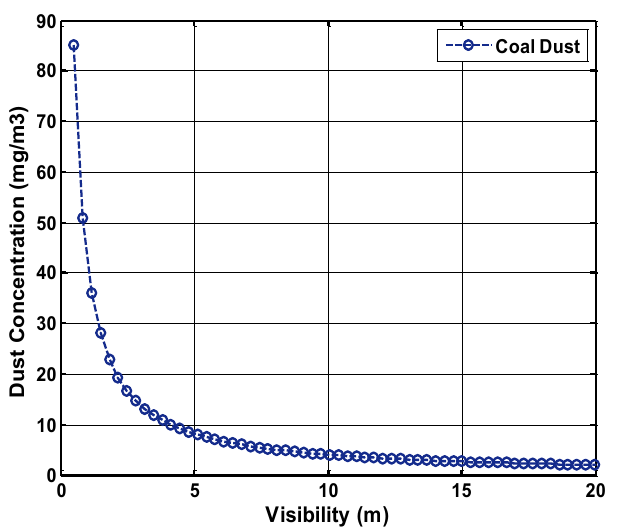
Figure 5. Estimation of coal dust concentration by using visibility